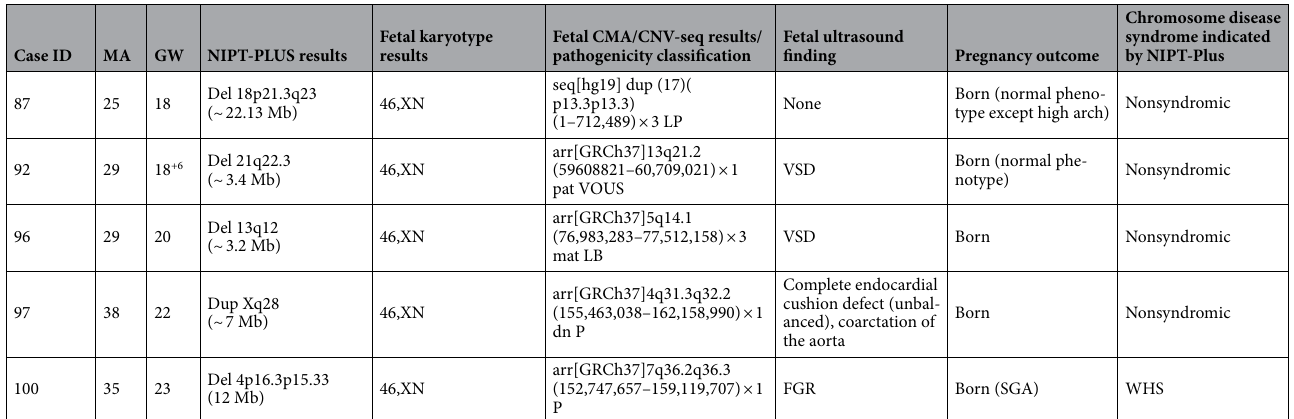
Table 2. A 101 fetal positive confirmatory invasive diagnostic testing results with fetal CNVs indicated by NIPT-Plus. MA maternal age, GW gestional weeks, LFU, TOP terminate of pregnancy, MS-MLPA methylation- specific multiplex ligation-dependent probe amplification, mat maternal, pat paternal, P pathogenic, LP likely pathogenic, VOUS variants of uncertain significance, CMA chromosomal microarray, CNV copy number variation, NIPT noninvasive prenatal testing, TS turner syndrome, UA ultrasound anomalies, WHS wolf- hirschhorn syndrome, XLR X-linked recessive, SGA small for gestational age, ARSA aberrant right abuclavian artery, VSD ventricular septal defect, FGR fetal growth restriction, HPE holoprosencephaly. *Fetal MS-PLPA: methylation-specific multiplex ligation-dependent probe amplification, paternal duplication. $ When there are multiple CNVs, only the highest pathogenicity classification is calculated.